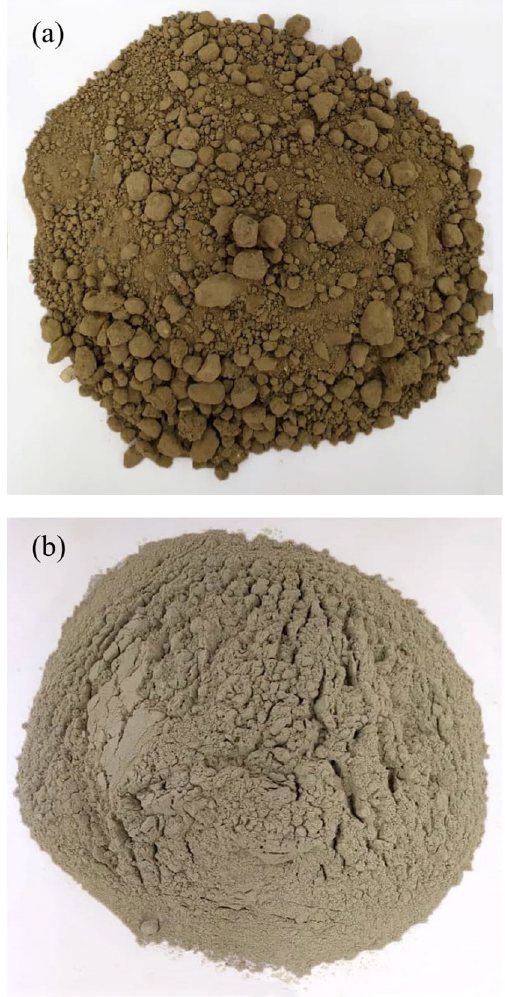
Figure 2. Materials used in this research: ( a ) clayey soil, ( b ) volcanic ash